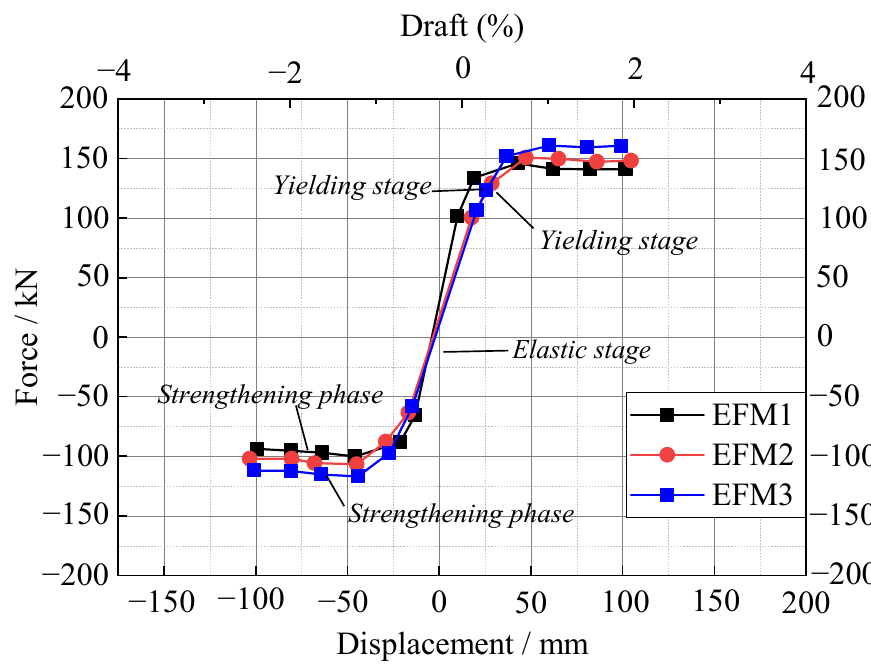
Figure 30. Skeleton curves of specimens at different axial compression ratios.